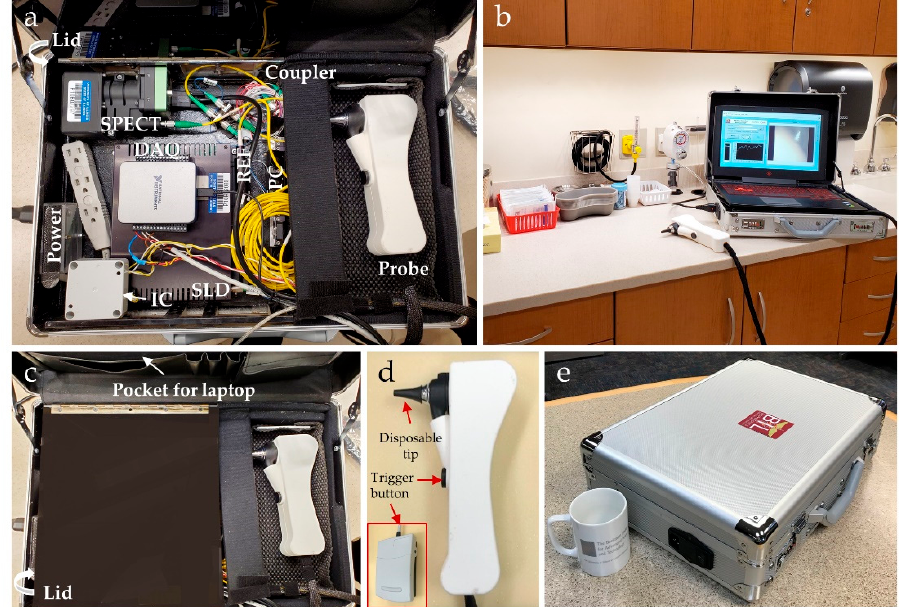
Figure 2. Photos of the complete ML-integrated briefcase system for ear imaging. ( a ) All components including associated optics, 3D-printed handheld probe and laptop fit into a standard briefcase; ( b ) briefcase system in an exam room for translational middle ear imaging; ( c ) a pocket stores the laptop during transport, and a lid protects the optical system from damage; ( d ) detailed view of the handheld probe with a disposable ear speculum and trigger buttons; ( e ) closed briefcase system with a standard coffee mug for size comparison. SPECT: spectrometer; IC: illumination circuit for a halogen lamp; REF: a reference arm that allows light to travel for a fixed distance in OCT; SLD: superluminescent diode; PC: polarization controller; DAQ: data acquisition system.